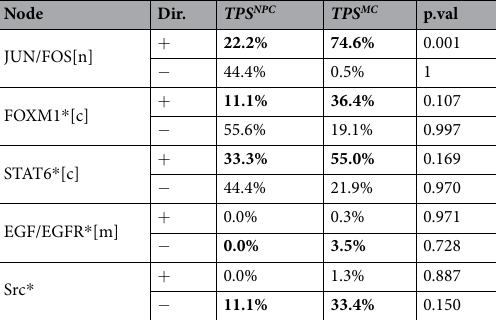
Table 4. Top perturbation score for nodes identified with the FS method. Dir stands for the direction of the perturbation ( + , activation and − , inhibition). TPS represents the frequency with which perturbing a node in a specific direction was significant (i.e. it generated a high, 10% top, SCENFIT score) across the MC profiles ( TPS MC ) or NPC profiles ( TPS NPC ). The bold percentages refer to perturbations that have a direction opposite to that of the predicted signs obtained with the frequency score (Table 3). P.val was obtained using a unilateral Fisher